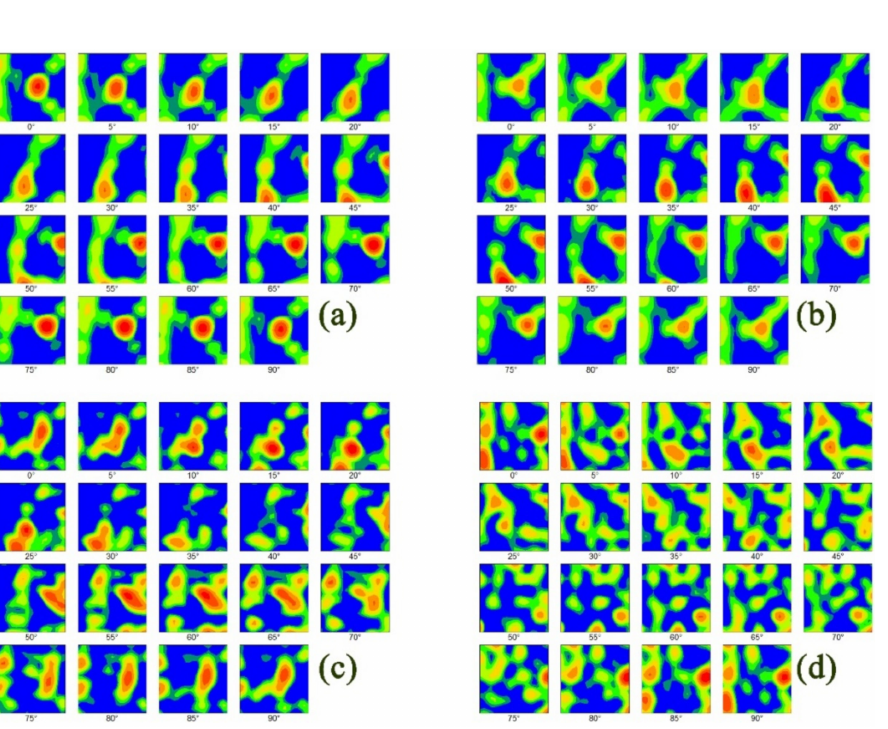
Figure 7. The ODF figures of the deformation areas of the samples tensiled at different temperatures: